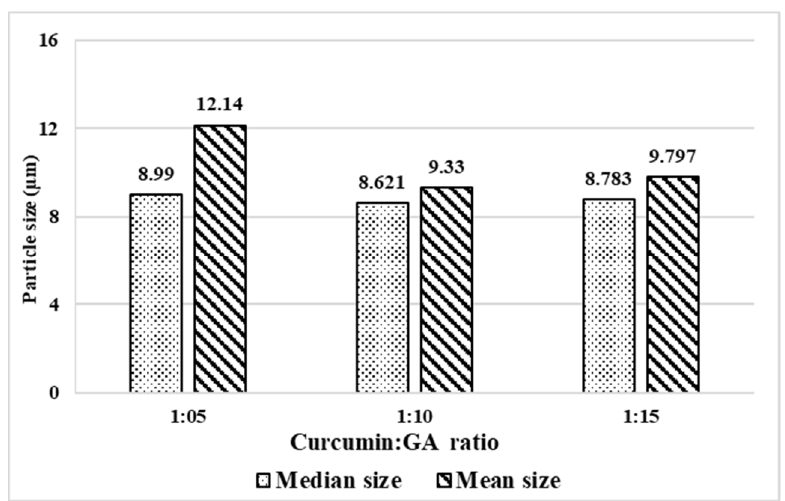
Figure 1. Effect of different curcumin:gum Arabic (GA) ratios on particle size of suspensions. Figure 1. E ff ect of di ff erent curcumin:gum Arabic (GA) ratios on particle size of